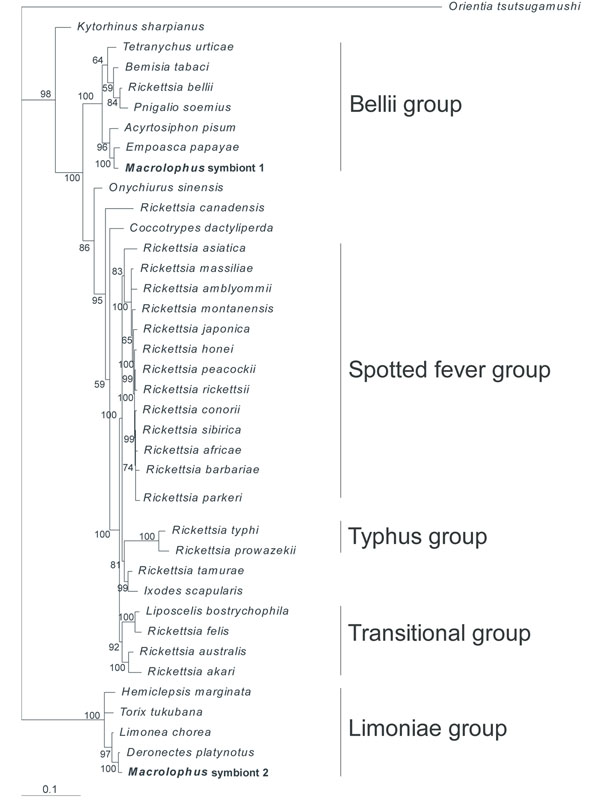
Phylogenetic tree of Rickettsia. Rooted phylogenetic tree estimated using Bayesian inference of phylogeny, based on concatenated sequences of 16S, gltA and coxA of Rickettsia. Posterior probabilities supporting nodes (> 50) are shown. The different Rickettsia-strains are indicated either as their species name or as their host species. Group names are indicated on the right.